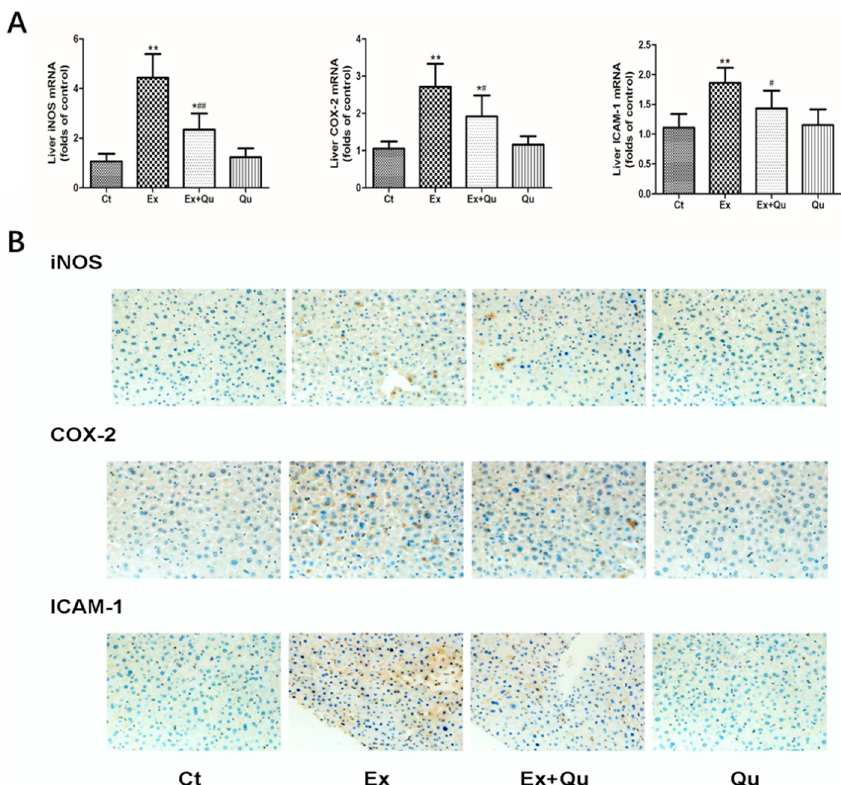
Figure 4. Quercetin decreased the expression of iNOS, COX-2 and ICAM-1 in mice liver subjected to intensive exercise. ( A ) mRNA expression determined by real-time PCR following normalization to β -actin; data expressed as fold-change compared to the control group (mean ± SD, n = 8); ( B ) protein expression determined by immunohistochemistry and observed by Olympus BX50 light microscope with HMIAS-2000 medical imaging system ( × 200). Ct—rested control; Ex—intensive exercise; Ex + Qu—Ex + quercetin; Qu—rested + quercetin. * p < 0.05, ** p < 0.01 vs. Ct; # p < 0.05, ## p < 0.01 vs. Ex.